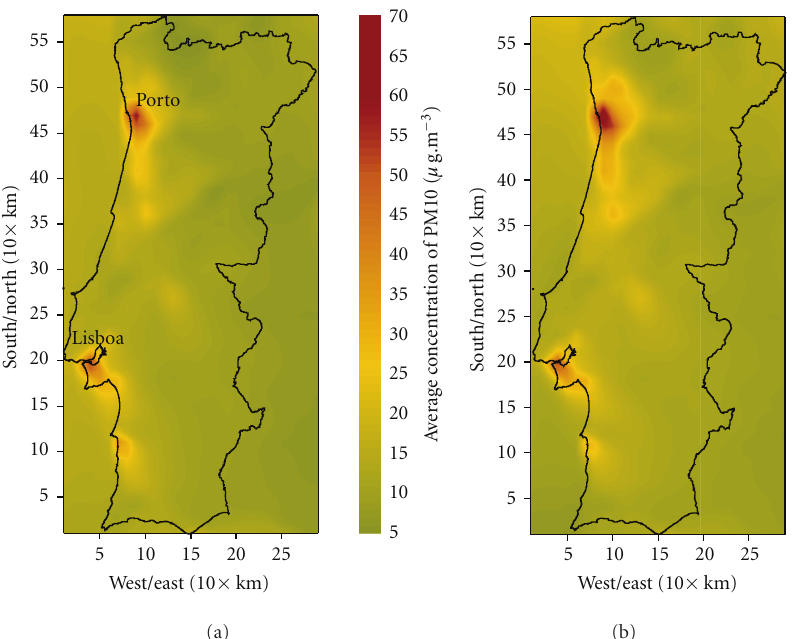
Figure 8: Average concentration of PM10 ( μ g · m − 3 ) for the simulated period (from May to October) for (a) current and (b) future climate scenario.